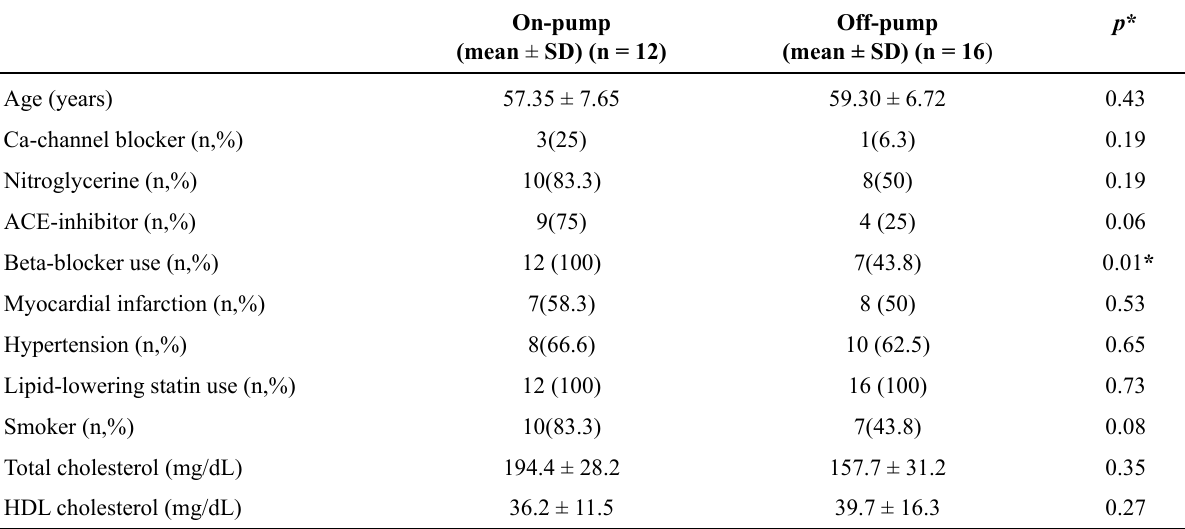
Table 1 - Demographic characteristics of on-pump and off-pump